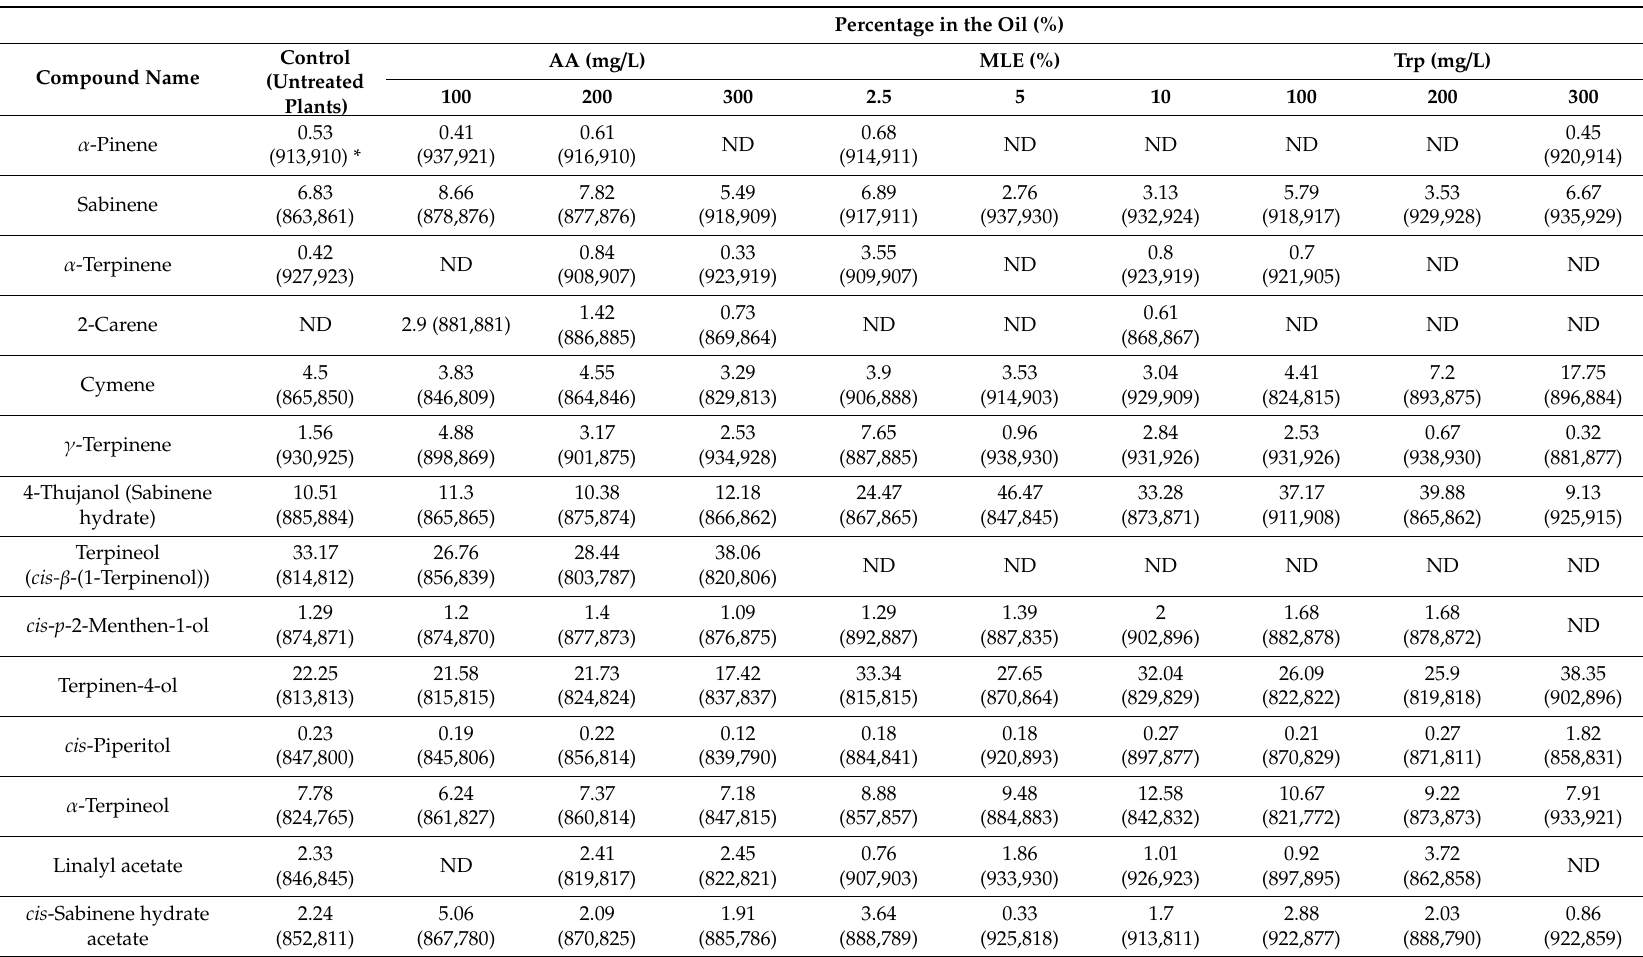
Table 3. Chemical compositions of the essential oils obtained from plants treated with AA, Trp and MLE. Percentage in the Oil